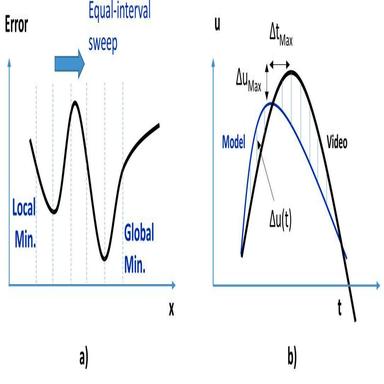
a) Search for the optimal parameter with minimum error by equal-interval sweep. b) The errors on the bulging at the center of gel used for the identification of optimal parameters.